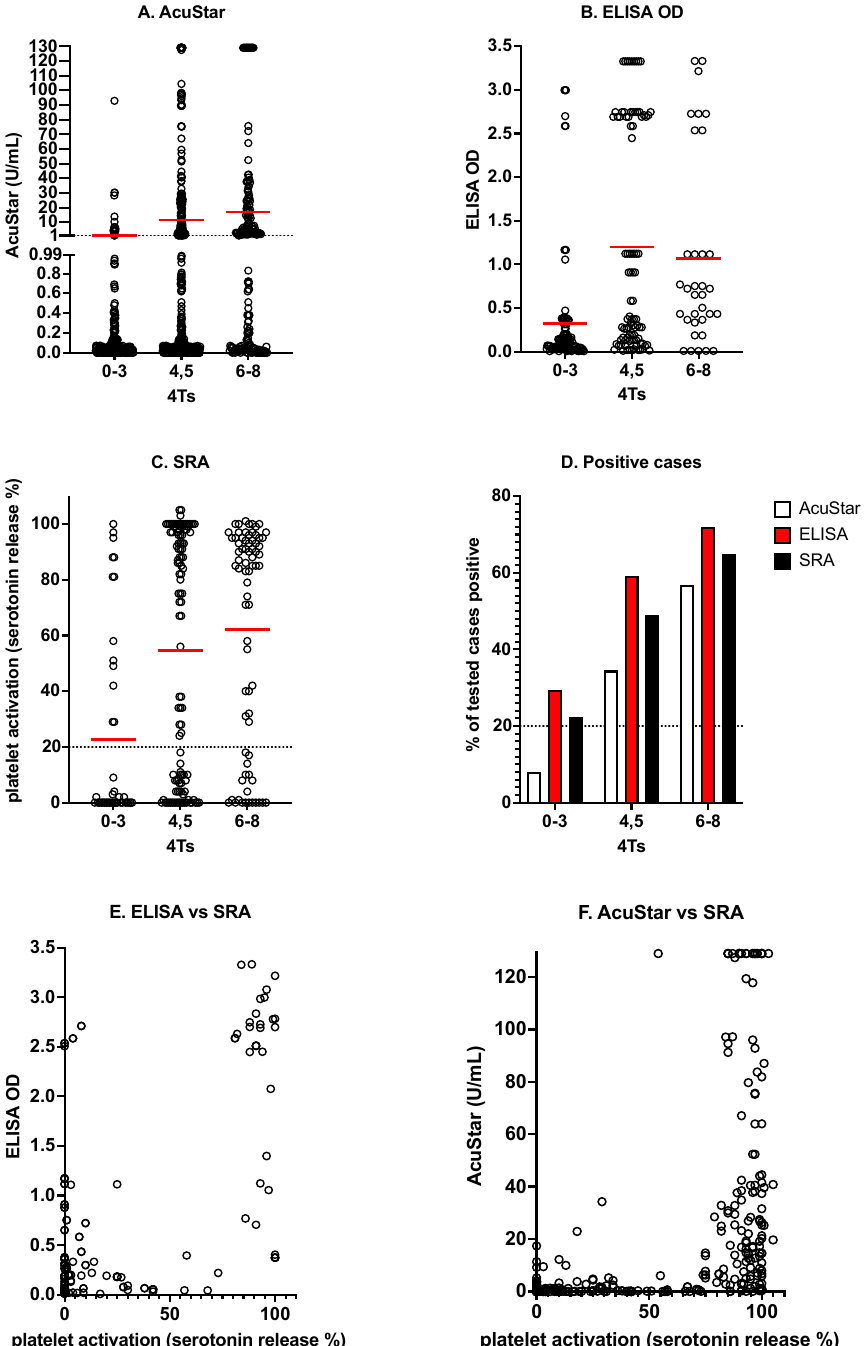
Figure 2. Some examples of testing for HIT according to 4T score (4Ts) and reactivity profiles. The higher the 4Ts, the more likely the presence of PF4/H antibodies. Thus, the higher the 4Ts, the higher the expected result in the AcuStar chemiluminescence assay ( A ), the higher the expected result by ELISA OD (optical density; ( B )), and the greater the expected level of platelet activation by SRA ( C ) (the red dash in each score group indicates the average value for the dataset). The higher the 4Ts, the higher the expected proportion of tested cases being positive by each assay ( D ). The higher the titer of immunologically detected PF4/H antibodies, the more likely the positivity in functional platelet activation assays ( E , F ). Data shown here are historical multicenter data, including from the Westmead laboratory, as partly previously reported [9,10]. OD, optical density.